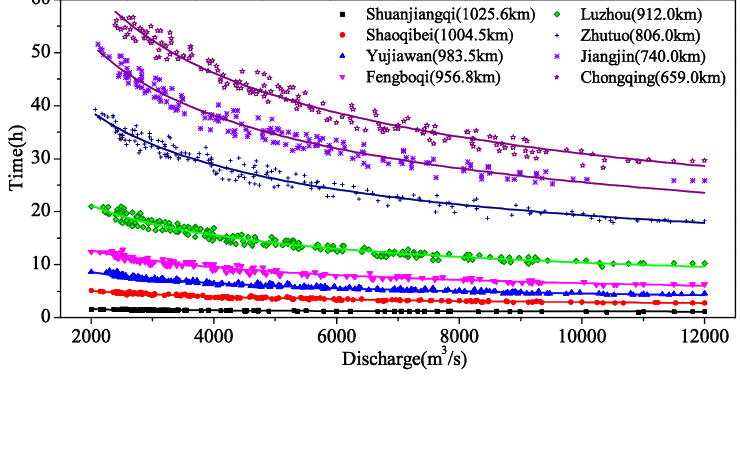
Table 2 Change in unsteady flow relationship Beach section